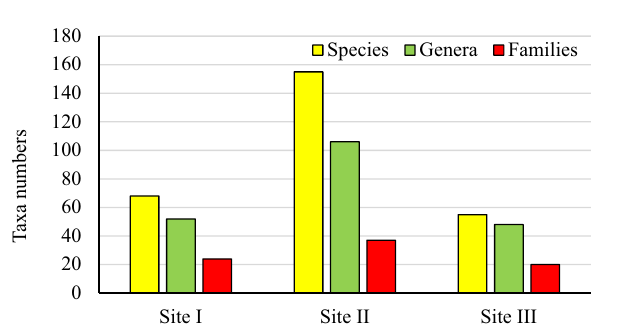
Figure 2. Taxa number recorded in the three sites.